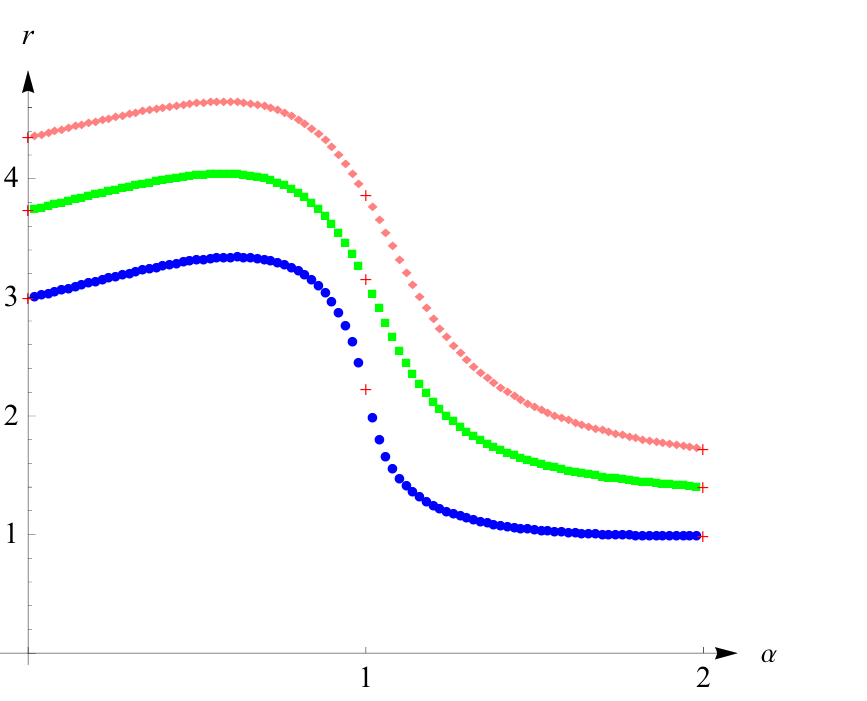
Figure 5. Curves of r ( α ) vs. α for b = 4 and for c = 5 (blue circular dots), c = 10 (green square dots) and c = 15 (pink rhombic